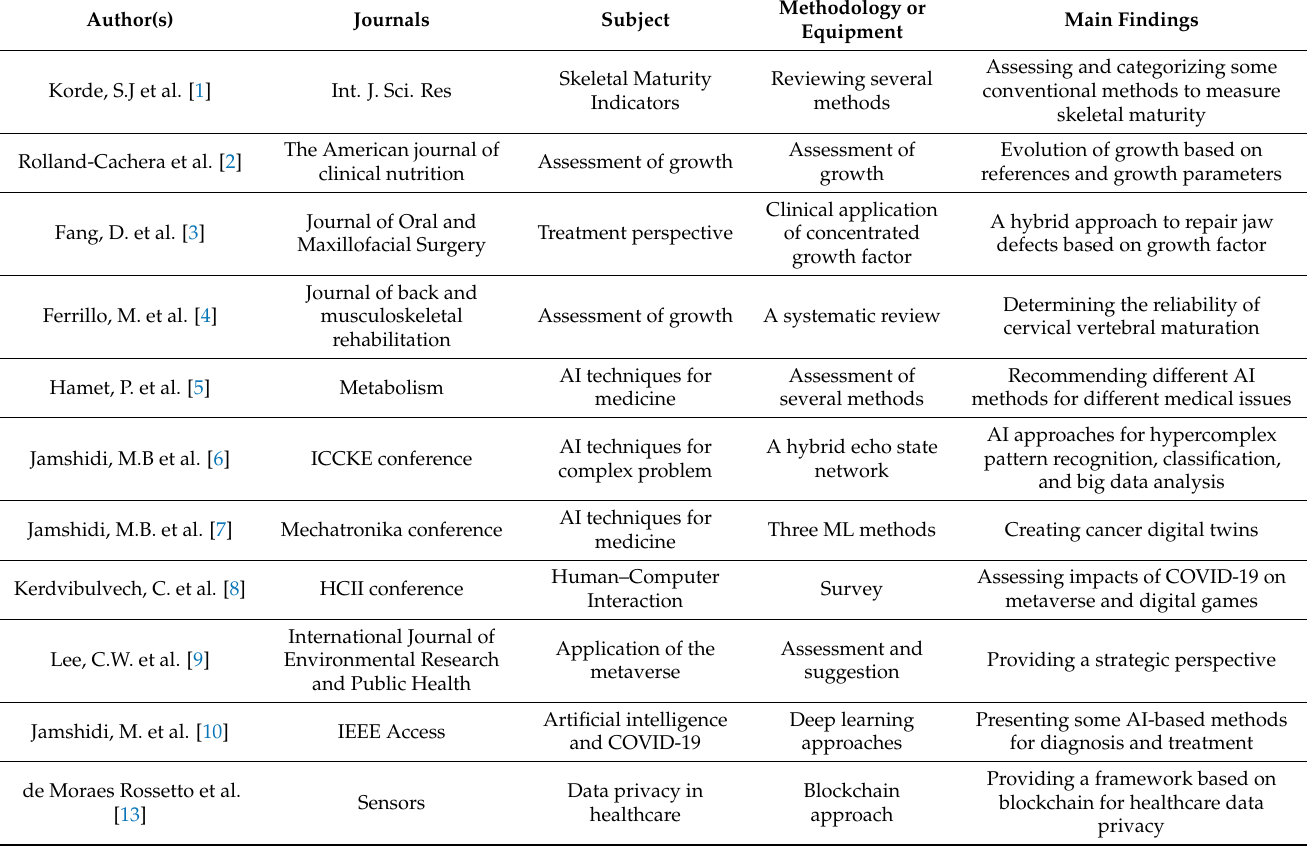
Table 1. An overview of the studies that are relevant to the proposed